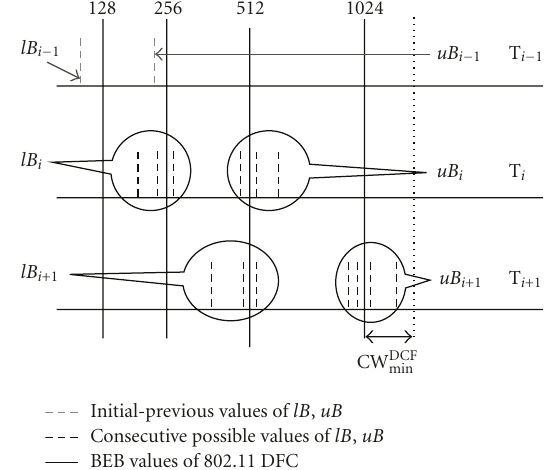
Figure 2: Bounds selection of EsB